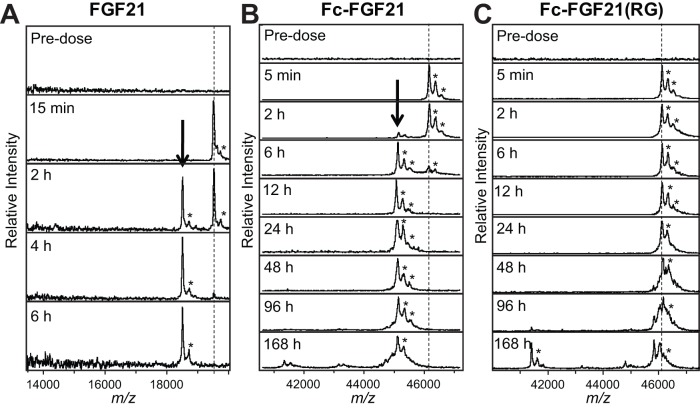
Fc-FGF21(RG) was resistant to degradation in cynomolgus monkeys.LBMS (MALDI-TOF) analysis of native FGF21 (A), Fc-FGF21 (B) or Fc-FGF21(RG) (C) in male cynomolgus monkeys. FGF21 (10 mg/kg) or Fc-FGF21 variants (23.5 mg/kg) were iv administered in cynomolgus monkeys and blood samples were collected at indicated time points. The mass positions of the parent constructs are indicated by vertical hashed lines. The peak marked with a heavy arrow corresponds to the primary metabolite of FGF21 or Fc-FGF21, which is absent in the Fc-FGF21(RG). Peaks marked with asterisks in all of the spectra correspond to sinapinic acid adducts of primary peaks and are an artifact of the ionization process of MALDI. The MALDI-TOF mass spectra are normalized to the most intense peak in the plotted m/z range.